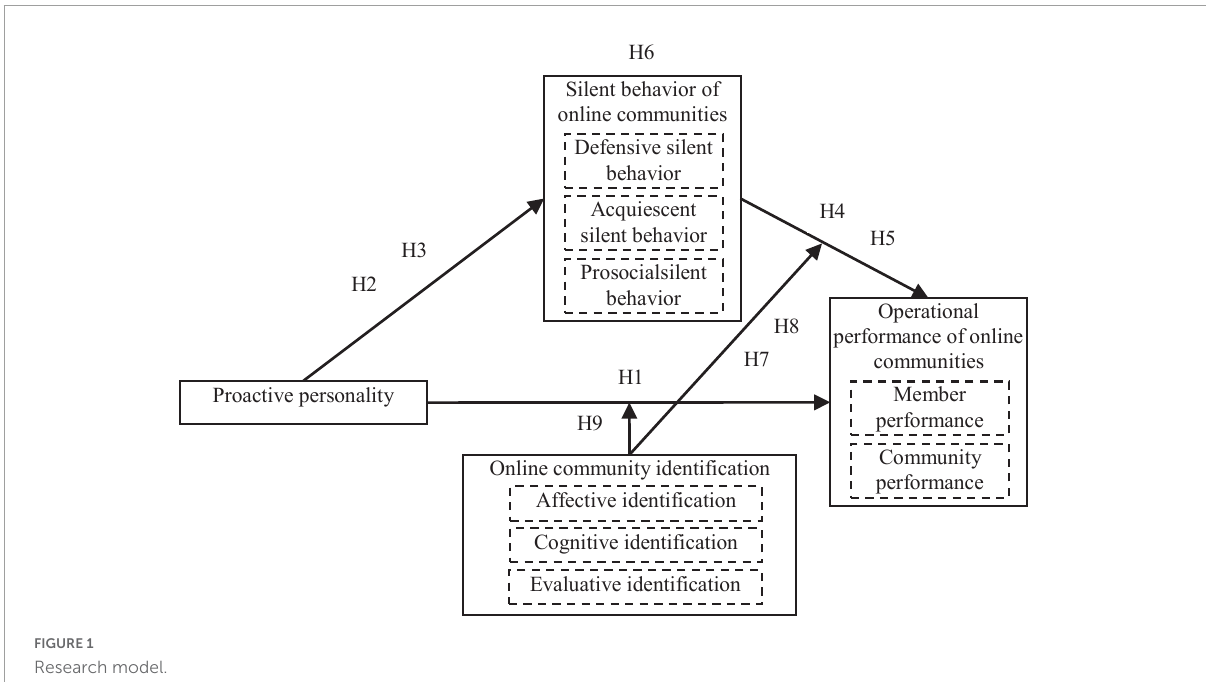
FIGURE1 Research